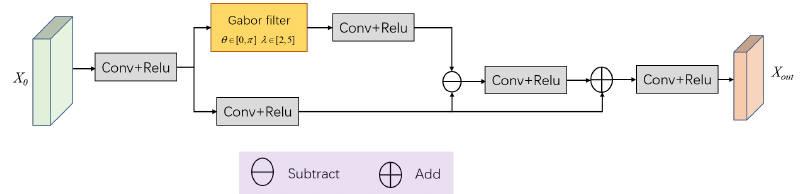
Figure 3. Block diagram of the Gabor feature extraction